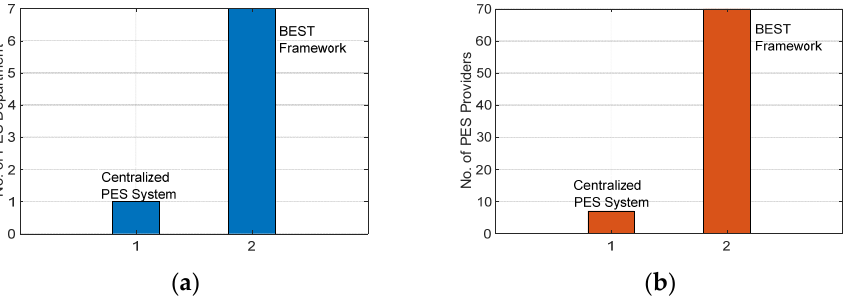
Figure 10. ( a ) A number of PES departments ( b ) Number of PES providers for the BEST framework and centralised PES system.